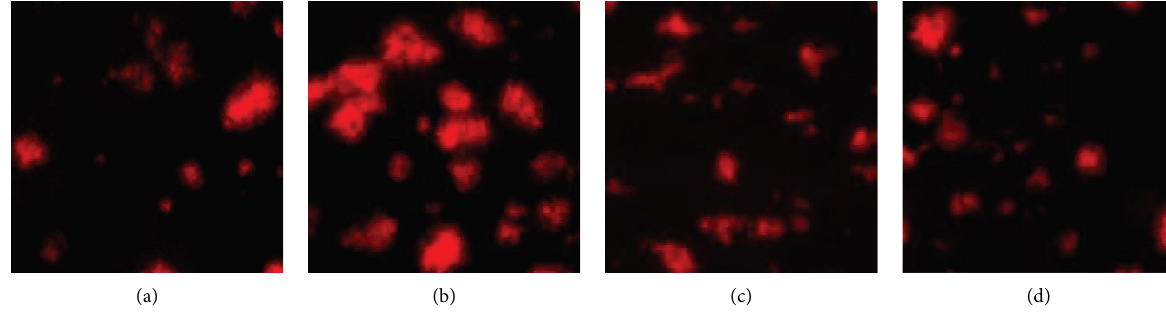
Figure 3: Platelet adhesion on collagen was evaluated under fow conditions after 5 min. (a) Negative control, (b) positive control, and (c) and (d) walnut bark extract (WBE) at 1 and 2 mg/mL, respectively, n � 3. Table 1: Efect of walnut bark ( Juglans regia ) on human PT and APTT.